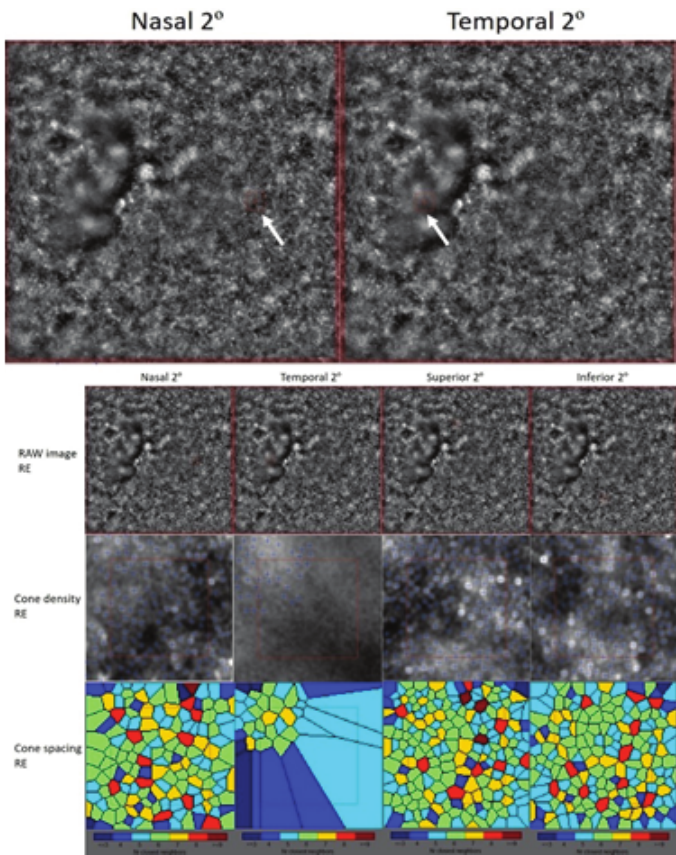
Figure 3. Adaptive optics imaging of the right eye in patient 3 with torpedo lesion. Raw images on adaptive optics imaging showing the exact site of cone density and spacing analysis (bold white arrow). Adaptive optics imaging showing raw images, cone density, and cone spacing of right eye at 2° from the foveal center in all four quadrants.